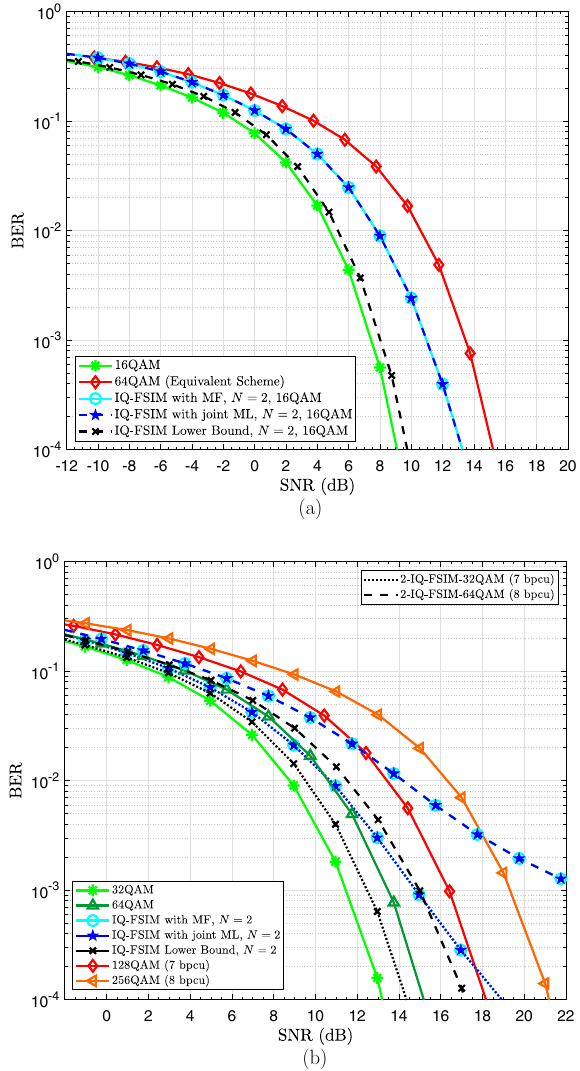
Fig. 10 BER performance for 2-IQ-FSIM- M QAM, its theoretical lower bound, and its equivalent scheme 4 M QAM of the same SE: a 6 bpcu using M = 16 , b 7 and 8 bpcu using M = 32 and M = 64 ,